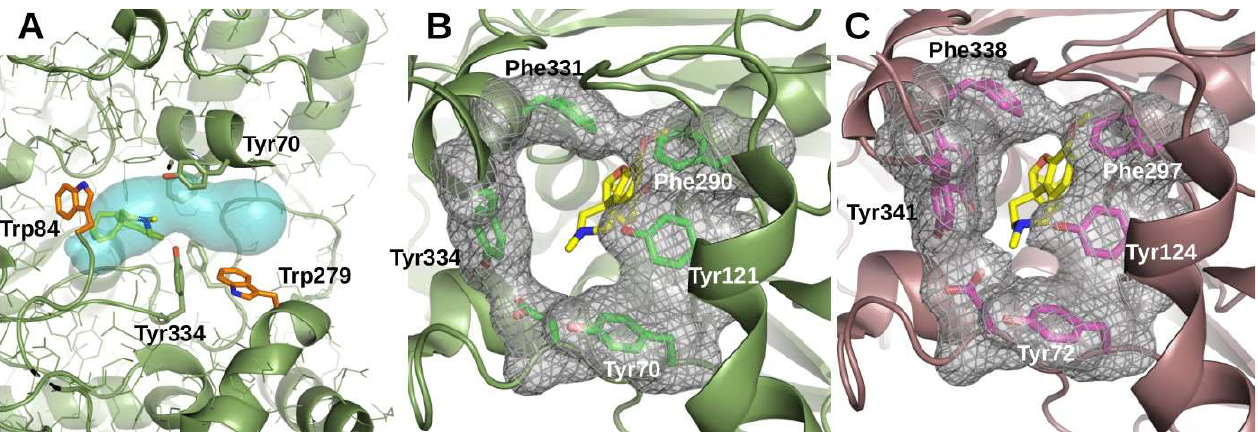
Figure 7. Structure of AChEs active site gorge. ( A ) Depiction of the crystal structure of Tc AChE (PDB 1EA5 [46]) showing the internal surface of the active site gorge (cyan, generated using CAVER [45] with a bound GAL molecule (yellow sticks, obtained from superimposition of PDB IDX6 [47]). Four aromatic residues, Tyr70, Phe290, Phe331 and Tyr 334 (green sticks), cause a narrowing of the gorge generally referred to as the bottleneck. Trp 279 and Trp 84 (orange sticks) mark the entrance and the bottom of the gorge, respectively. ( B , C ) View of a section of the active site gorge of the apo form of the Tc AChE ( B , PDB 1EA5 [46]) and of the enzyme from human brain ( C , PDB 4EY4 [48]) seen along the main axis and showing the bottleneck lumen. Residues lining the bottleneck are shown in stick and their van der Waals surface is shown as a gray mesh. Geometric analysis of the gorge performed with CAVER [45] evaluated the opening through the gorge narrowing to have a solvent accessible area of 28 Å 2 in Tc AChE and of 14 Å 2 in HuAChE. Behind the bottleneck, depicted in yellow stick, is shown the GAL inhibitor bound in the active site at the bottom of the gorge, obtained from superimposition of the AChE-GAL crystallographic complexes PDB ID 1DX6 [47] for T. californica and PDB ID 4EY6 [50] for the human enzyme. Created using PyMol [49].